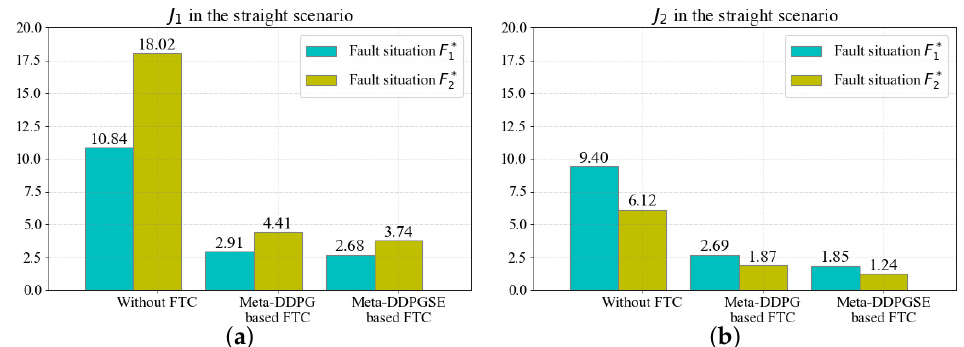
Figure 9. The quantitative evaluation in the straight scenario: ( a ) J 1 in the straight scenario; ( b ) J 2 in the straight scenario.